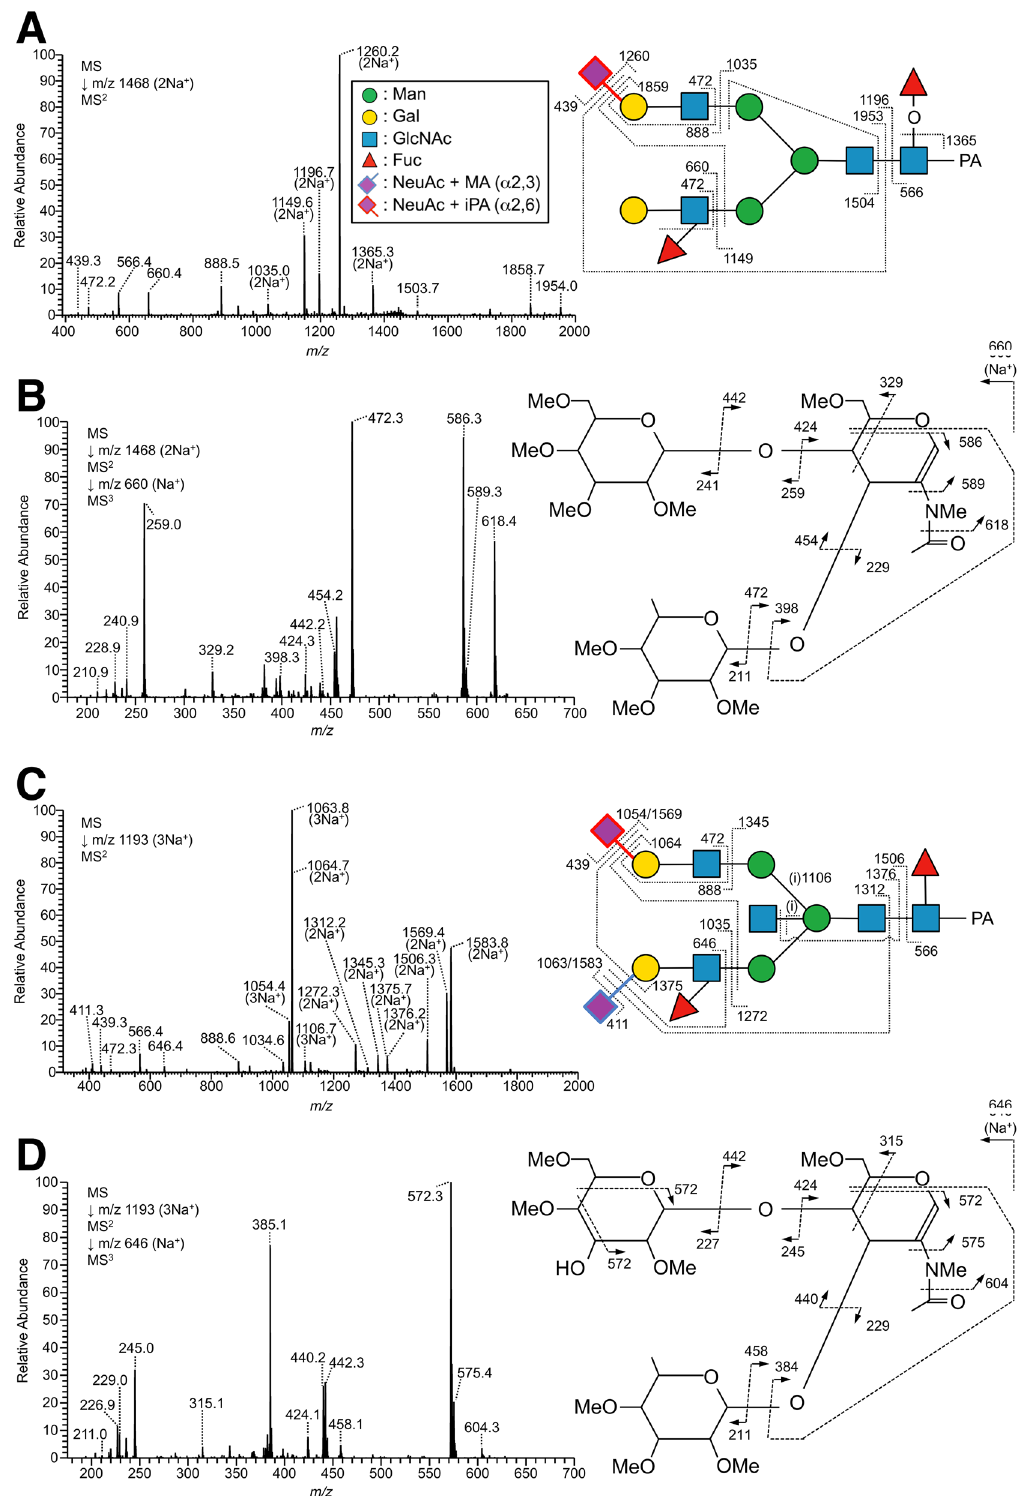
Figure 3. MS n analysis of alkylamidated and permethylated PA- N -glycans from chicken trachea. ( A ) MS 2 spectrum of PA- N -glycans with Le x from the doubly sodiated precursor ion at m/z 1468, corresponding to Hex 2 HexNAc 2 Fuc 2 (NeuAc + iPA) 1 C-PA. The branch positions of each glycan sequence linked to α3- or α6-Man were not determined. ( B ) MS 3 spectrum of the B ion fragments Hex 1 HexNAc 1 Fuc 1 at m/z 660. ( C ) MS 2 spectrum of PA- N -glycans with sLe x from the triply sodiated precursor ion at m/z 1193, corresponding to Hex 2 HexNAc 3 Fuc 2 (NeuAc + MA) 1 (NeuAc + iPA) 1 C-PA. The branch positions of each glycan sequence linked to α3- or α6-Man were not determined. ( D ) MS 3 spectrum of the B/Y ion fragments Hex 1 HexNAc 1 Fuc 1 at m/z